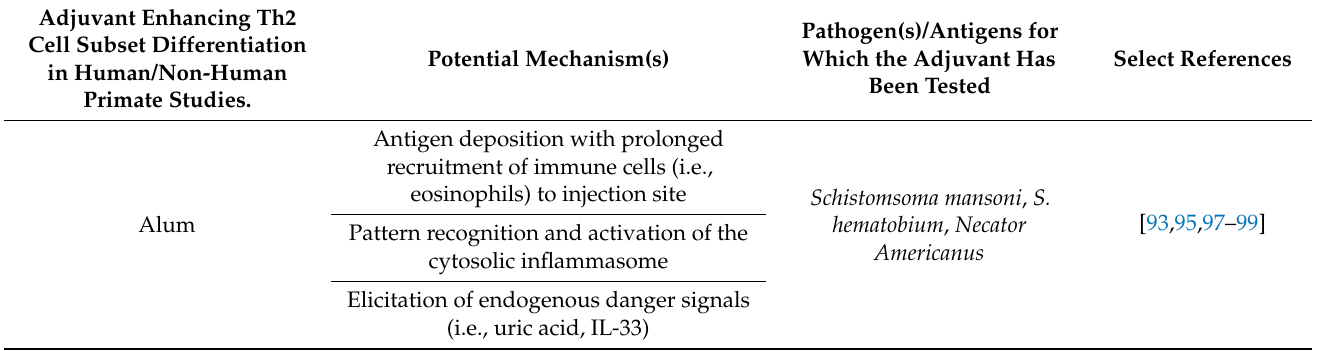
Table 4. Adjuvants enhancing Th2 cell subset differentiation in human/non-human primate studies. Adjuvant Enhancing Th2 Cell Subset Differentiation in Human/Non-Human Primate